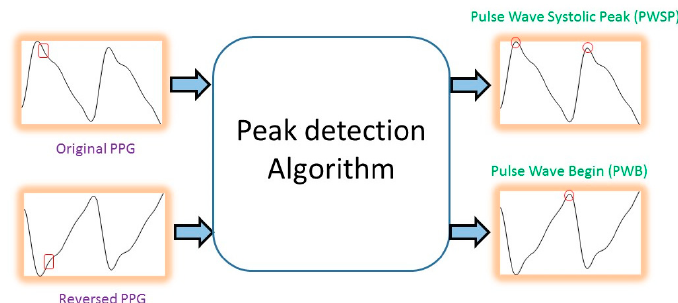
Figure 6. Detection of the pulse wave systolic peak (PWSP) and pulse wave begin (PWB).